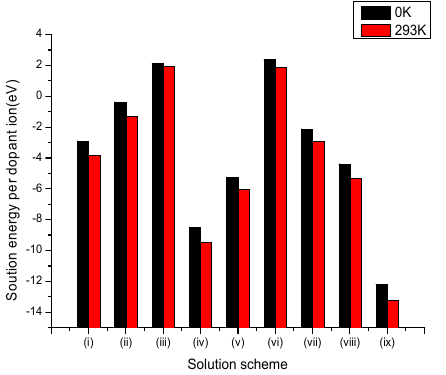
Figure 4. Bar chart of solution energies vs. solution schemes for tetravalent dopant (V 4 + ) at the Li and Nb sites, considering the first neighbours in relation to the c axis.